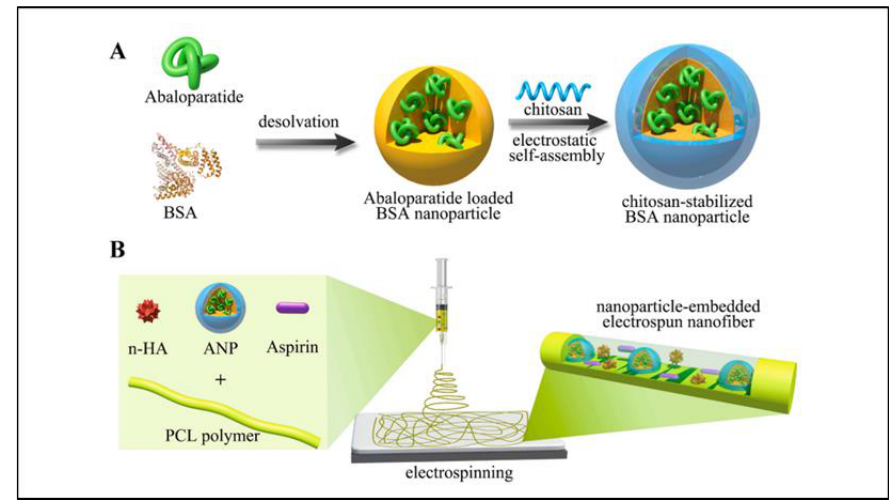
Figure 2. Schematic illustration of ( A ). Synthesis of chitosan stabilized BSA nanoparticle by desolvation approach; ( B ). Fabrication of PCL-based electro-spun nanofiber loaded with nano-hydroxyapatite, abaloparatide loaded BSA nanoparticle and aspirin. (Reproduced with permission from [37]; Copyright 2022, Elsevier).